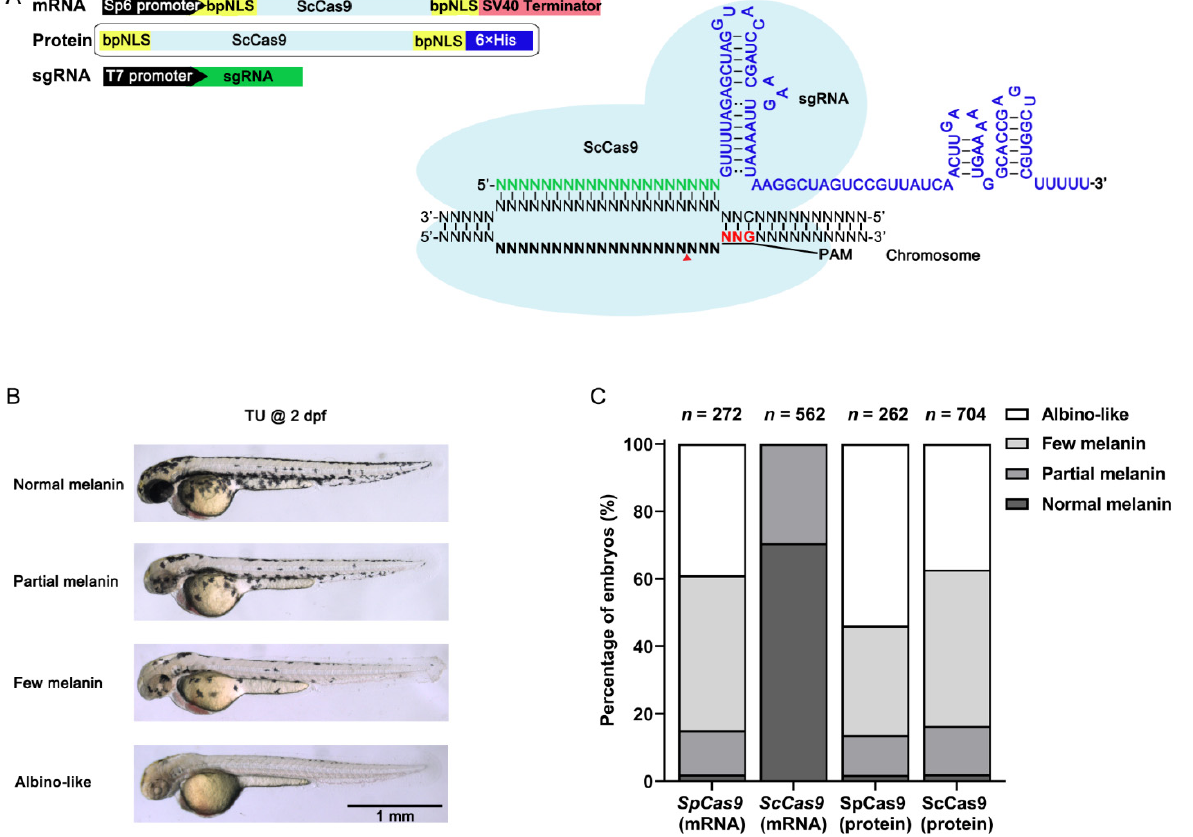
Figure 1. ScCas9 mRNA and protein induced tyr gene editing in zebrafish. ( A ), Schematic illustrating the ScCas9 system used in zebrafish. The ScCas9 system consists of two components, a dual bpNLS-tagged zebrafish codon-optimized ScCas9 protein and a sgRNA comprising a 20-nt seed sequence (green) infused with a sgRNA scaffold (blue). The ScCas9-bpNLS mRNA was transcribed in vitro from Sp6 promoter and sgRNA was transcribed from T7 promoter. ScCas9 protein tagged with bpNLS and His-tag was induced expression in vitro. Red triangle indicates the double stranded break sites induced by Cas9. bpNLS, bipartite nuclear localization signal; His, histidine tag. ( B ), Phenotypic evaluation of embryo pigment levels induced by targeting tyr using ScCas9 according to the amount of melanin. ( C ), Statistics of gene editing efficiency in the tyr target site induced by SpCas9 mRNA, ScCas9 mRNA, SpCas9 protein and ScCas9